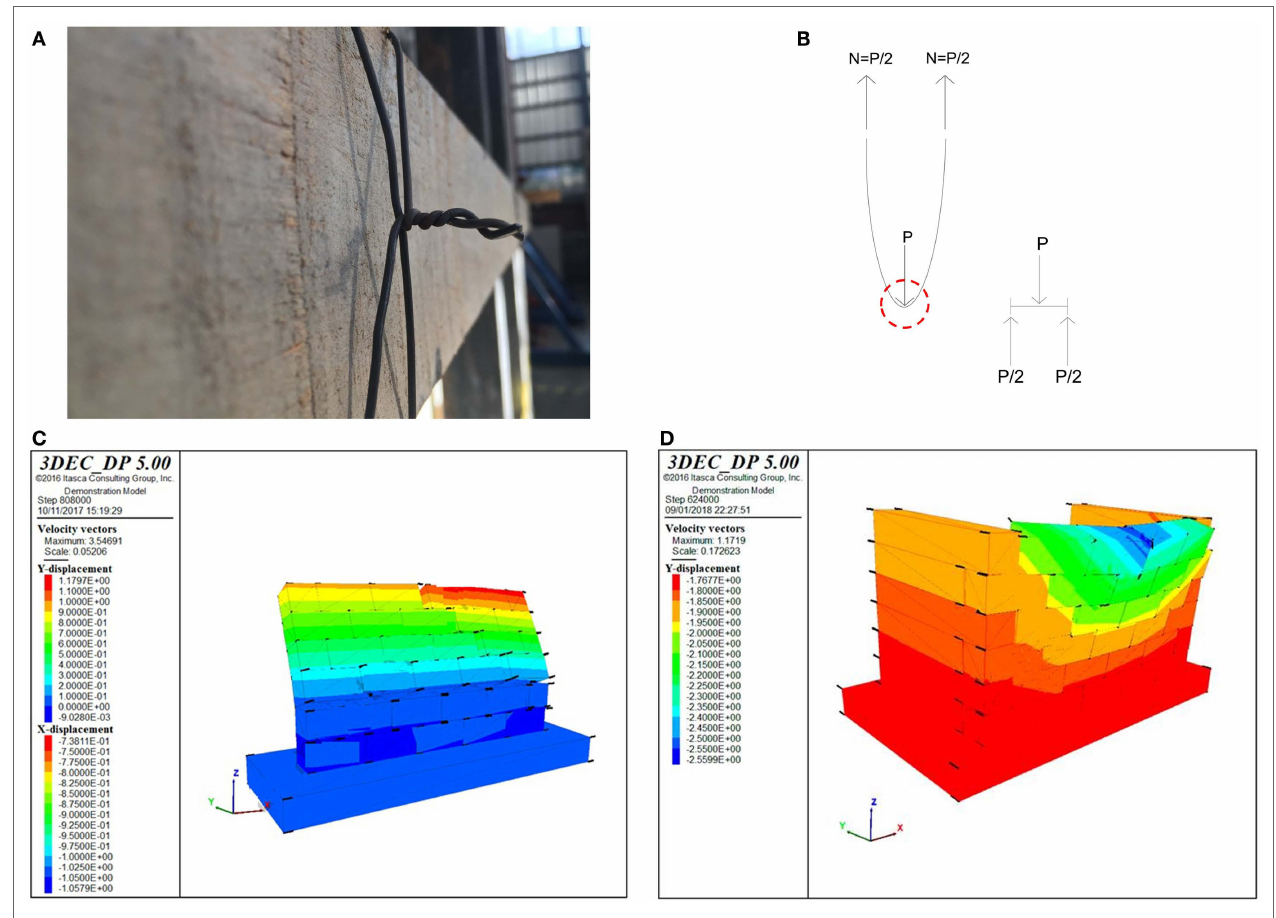
FIGURE 15 | (A) Typical steel wire knot. (B) Knot schematization for strength estimation. (C) Collapse mechanism for model I2-R (0.45g). (D) Collapse mechanism for model O3-R (0.27g).